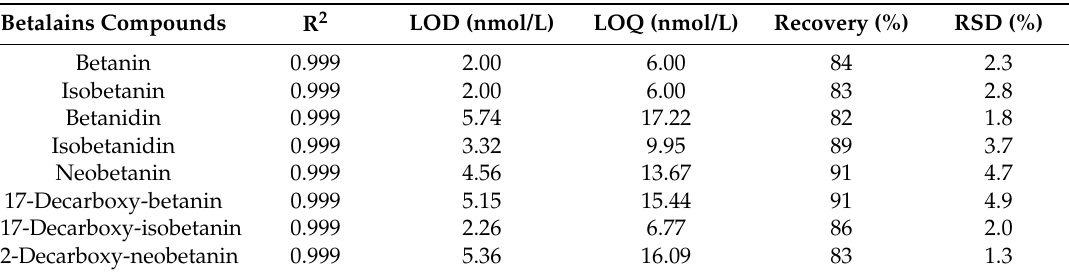
Table 1. Data of betalains